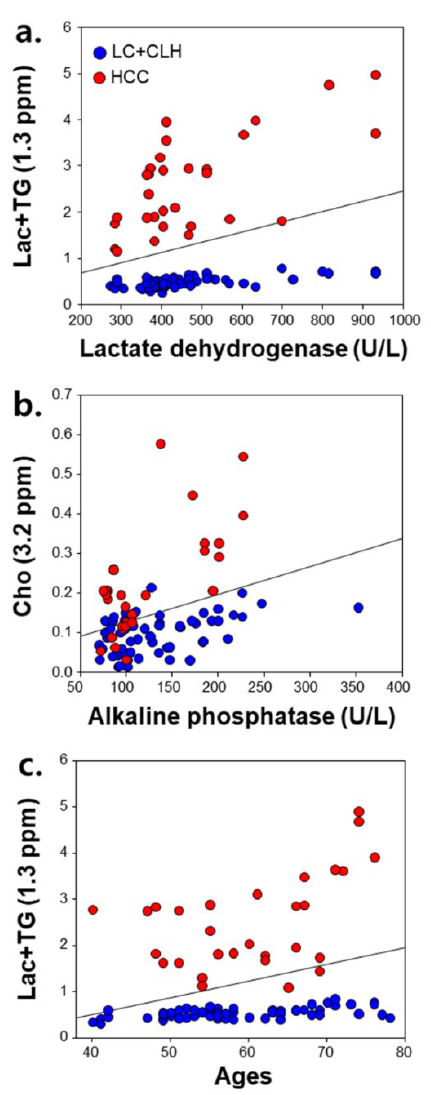
Figure 3. Correlations of metabolite concentrations with enzymatic activities and age in LC and CLH (blue), and HCC (red) groups. Lac+TG and Cho concentrations were positively correlated with lactate dehydrogenase activity (γ = 0.299, p = 0.004) (a) and alkaline phosphatase activity (γ = 0.338, p = 0.001) (b), respectively. Lac+TG concentration was also positively correlated with age (γ = 0.316, p = 0.003) (c). LC, liver cirrhosis without HCC; CLH, cirrhotic liver with HCC; HCC, hepatocellular carcinoma; Lac+TG, lactate+triglyceride; Cho, choline.